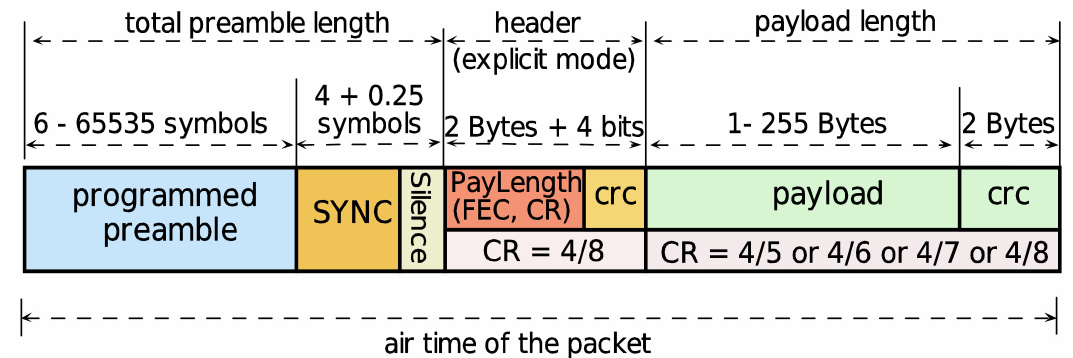
Figure 3. The radio PHY structure is composed of several fields that can be transmitted by the LoRa ED